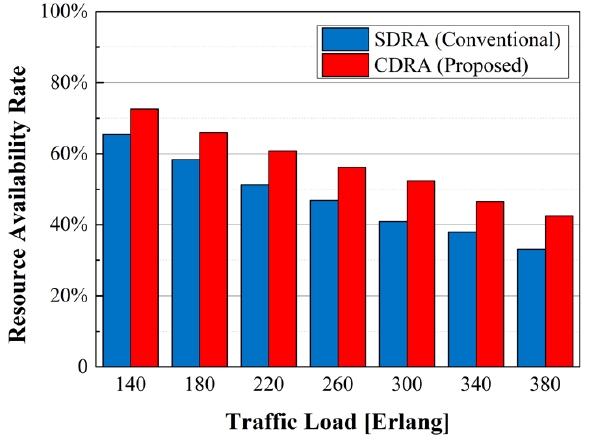
Figure 9. Performance comparison in terms of resource availability rate.